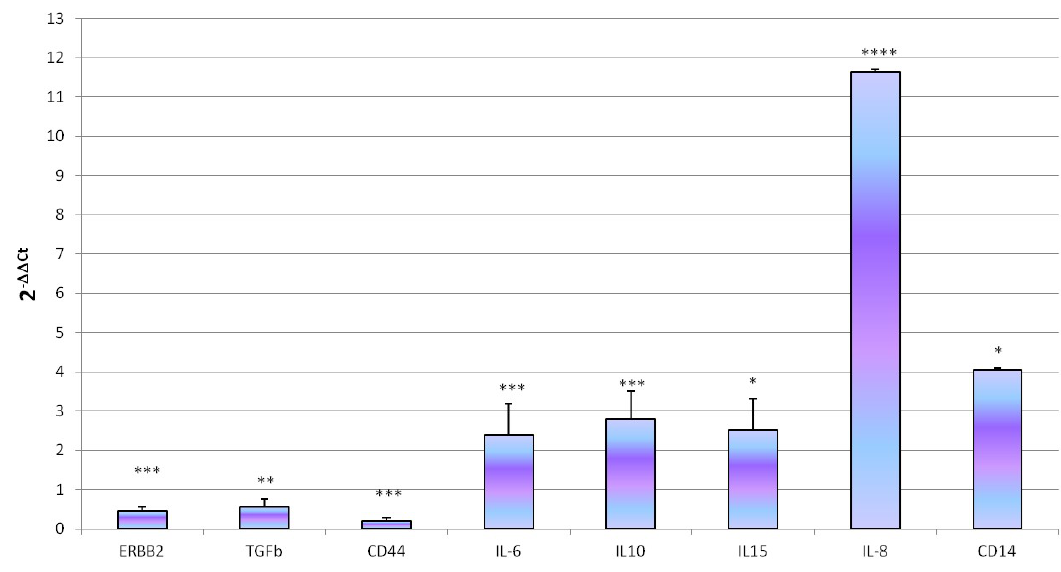
Figure 5. E ff ect of ST treatment on D-17 genes expression. Genes expression was measured after treatment of D-17 cells with 1 mL of bacterial suspension (MOI 100 ufc / cells) for 1 h at 37 ◦ C in 5% CO 2 . Data are expressed as 2 - ∆∆ Cq , values are the mean of three test replicates ± 1 standard deviation and ∆∆ Cq = ∆ Cq ( ST treatment)— ∆ Cq (untreated control). Negative samples were given a Cq 39 fictitious value. Asterisks indicate significant di ff erences: * p < 0.05, ** p < 0.01, *** p < 0.001 and **** p < 0.0001. (Not significant changes in genes expression were not